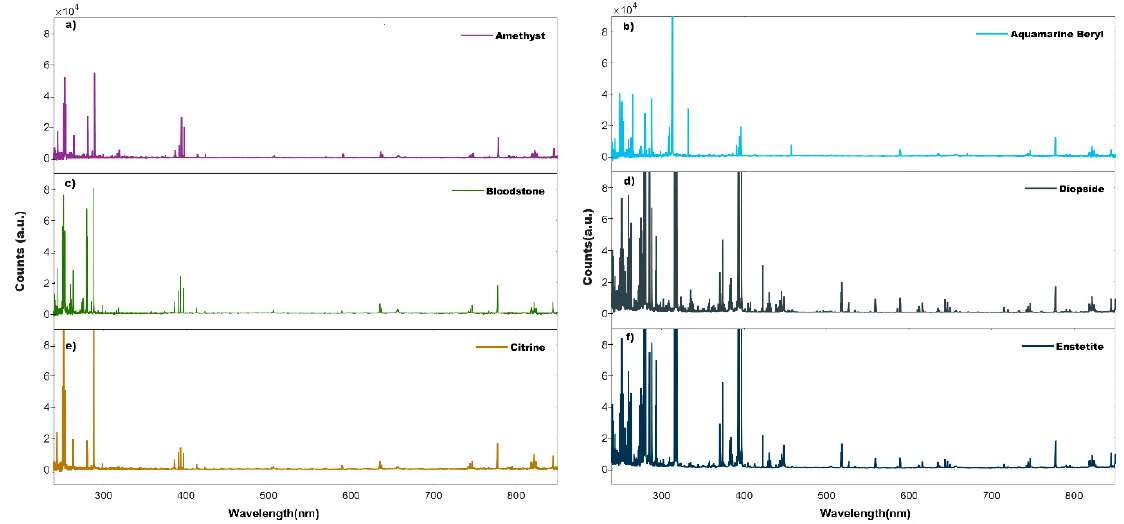
Figure 3. Average LIB spectra of gemstone samples. ( a ) Amethyst, ( b ) aquamarine beryl, ( c ) bloodstone, ( d ) diopside, ( e ) citrine, and ( f ) enstatite in the wavelength range of 230–850 nm. Table 2. Elements observed and their corresponding wavelengths in gemstone samples. Wavelengths are given in